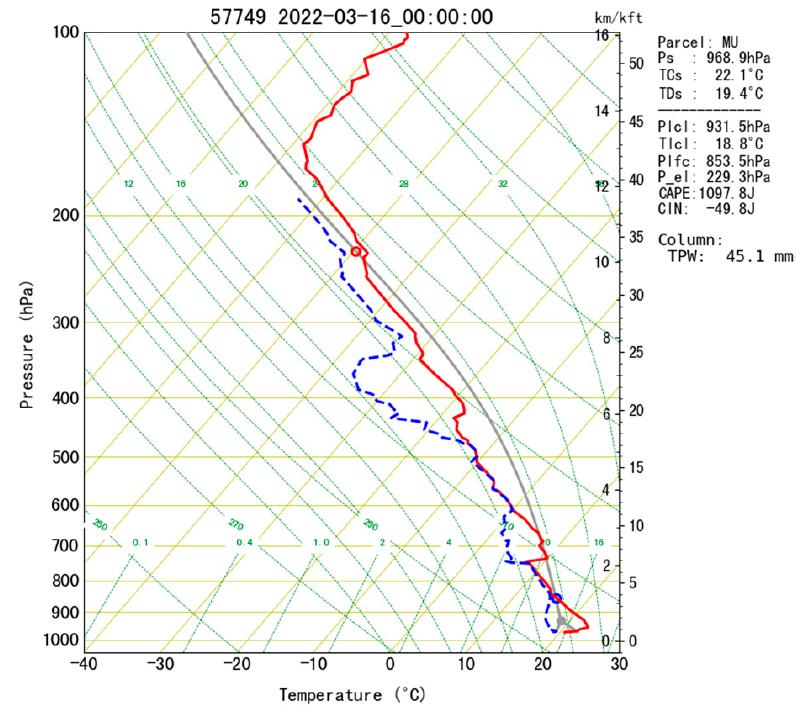
Figure 3. Skew T-logP diagram for Huaihua (triangle in Figure 1) at 0000 UTC on 16 March 2022. The red and blue lines show temperature and dewpoint temperature profiles, respectively. The gray curve represents the ascending path of the most unstable parcel. The yellow background line, sloped at a 45° angle, denotes temperature lines.